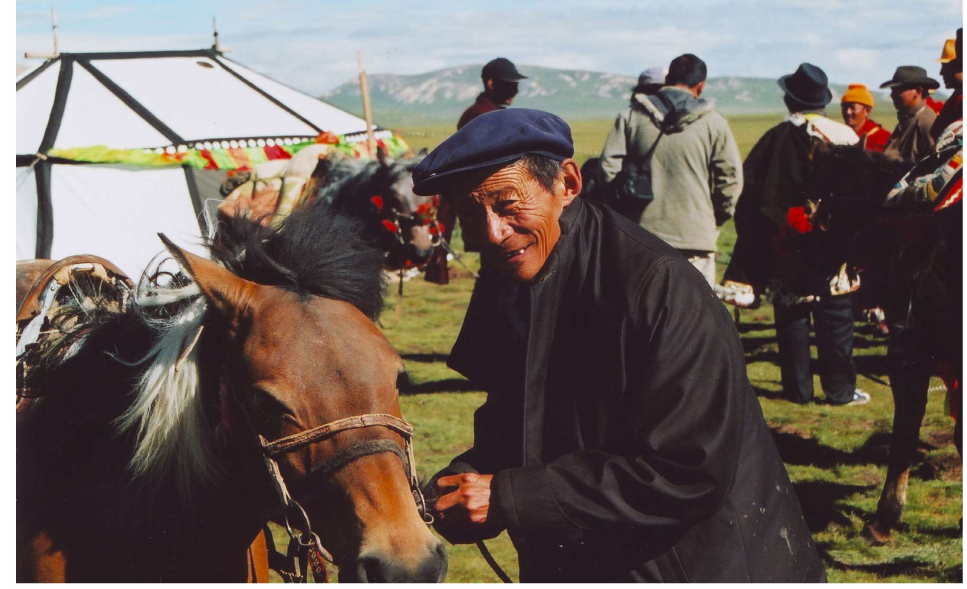
Figure 8. Jiongqu village leader at a co-management planning meeting on the grassland, circa 2007.